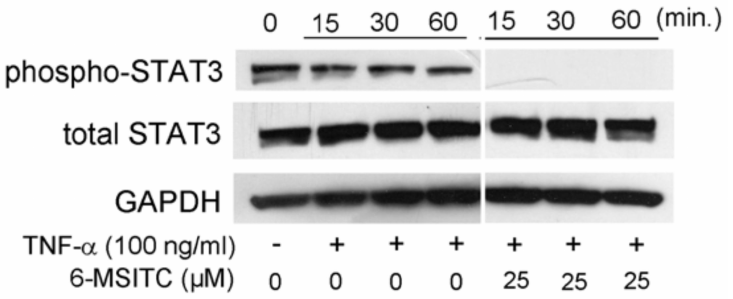
Figure 3. 6-MSITC mediated inhibition of a STAT3 pathway in TNF- α stimulated TR146 cells. After pretreatment with 6-MSITC (25 µ M) for one hour, TR146 cells were stimulated with TNF- α for 15, 30, or 60 min, and then phosphorylation of STAT3 was determined by Western immunoblotting. The figure reports the results of a representative experiment performed three times with qualitatively comparable